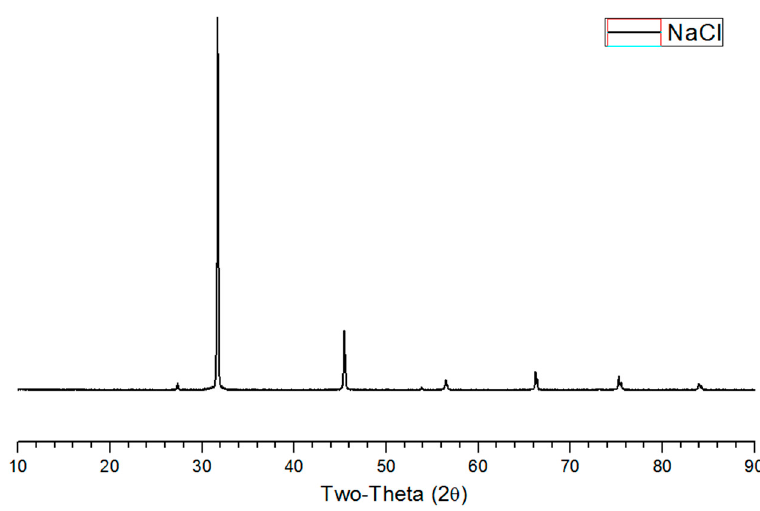
Figure 5. The XRD result of NaCl.